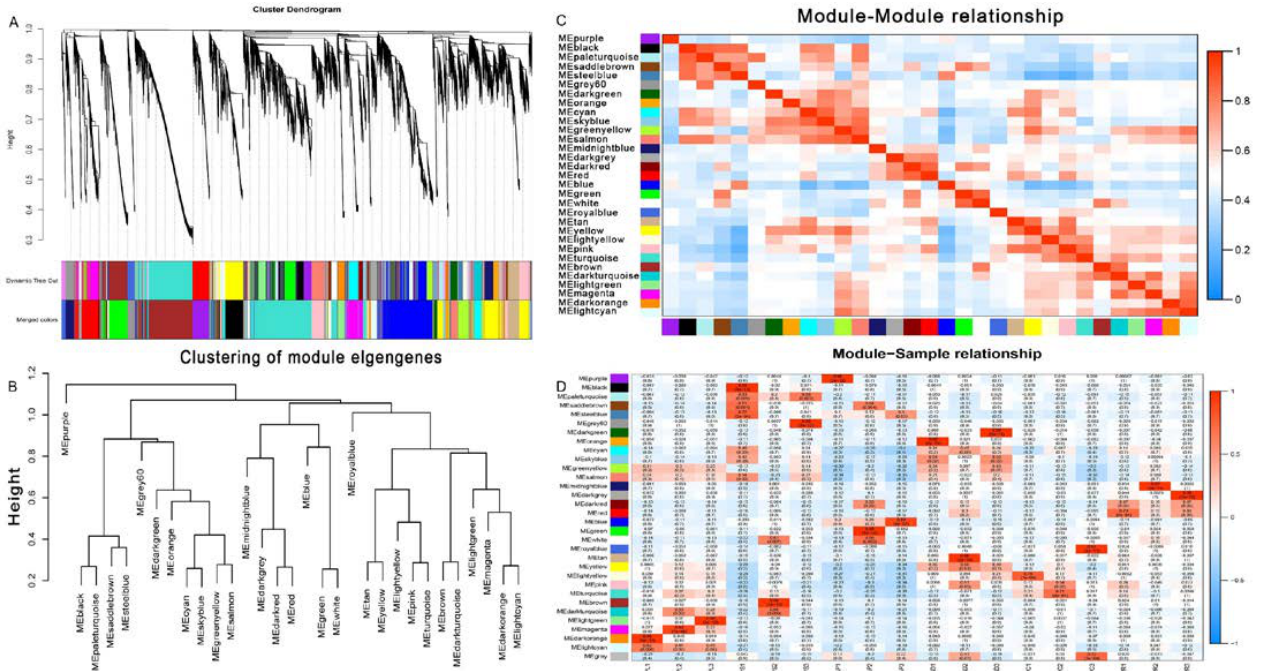
Figure 8. Weighted gene correlation network analysis (WGCNA) and module detection. ( A ) Cluster dendrogram and module assignment for modules from WGCNA. ( B , C ) Meta-module identification and module–module relationship. The module network dendrogram was constructed by clustering module eigengene distances. ( D ) The expression patterns of modules are shown as a heatmap. The color bar indicates expression levels of genes from high (red) to low (blue).